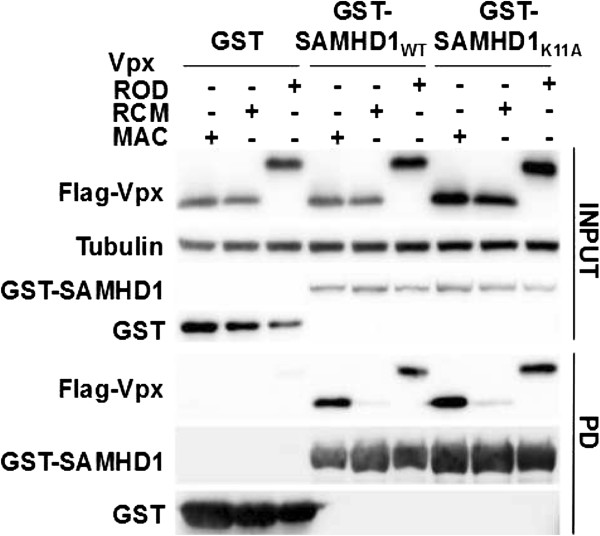
SAMHD1WT and SAMHD1K11A bind VpxMAC with similar efficiencies. 293 T cells were co-transfected with plasmids expressing GST, GST-SAMHD1 or GST-SAMHD1K11A along with plasmids expressing Flag-tagged Vpx derived from HIV-2ROD, SIVMAC or SIVRCM. GST-pull down was performed and samples were separated using 15% SDS-PAGE gels. Vpx proteins were detected using an anti-Flag antibody, and SAMHD1 was detected using an anti-GST antibody. Tubulin served as a loading control for the input.